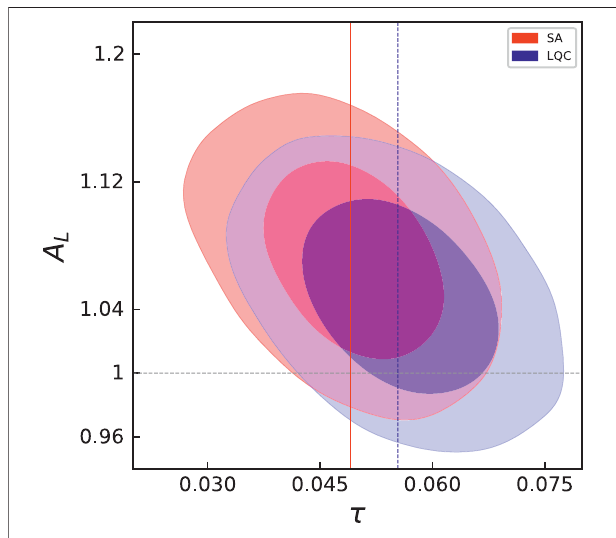
− τ plane. L Predictions ofthe SA (in red) and LQC (in blue). Verticallines denote the mean values of τ for the SA and LQC. It is evident that A L (cid:1) 1 is outside the 1 σ contour for the SA while is restored within 1 σ for the LQC